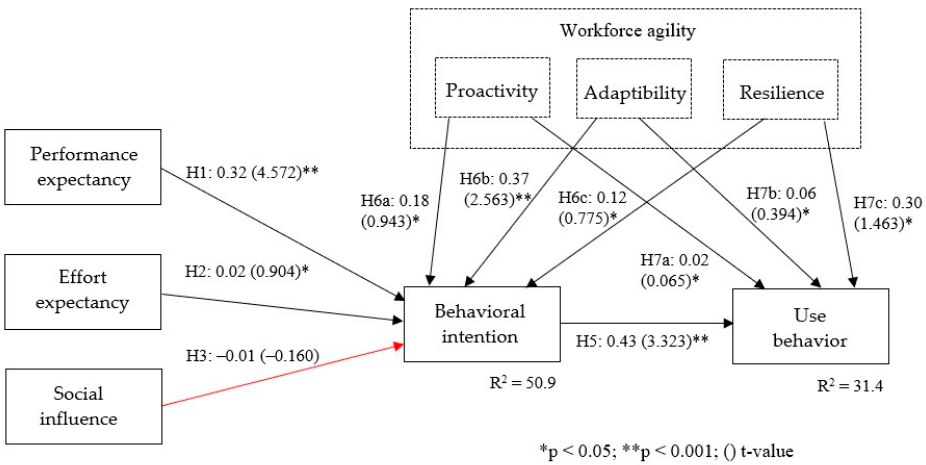
Figure 3. PICB—SEM Figure 3. PICB—SEM model.